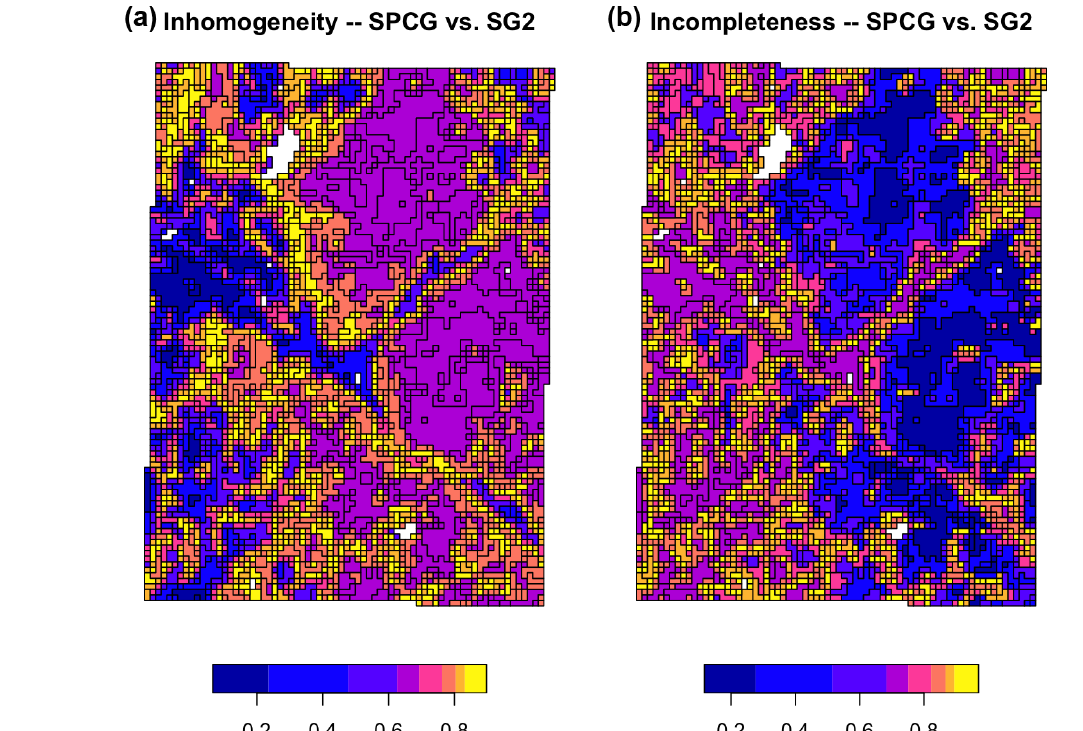
Figure 17. Homogeneity (a) and completeness (b) measures of the SG2 pH class map, with respect to the SPCG pH class map, at 0–5cm. The values are the inhomogeneity of each zone (a) and the incompleteness of each region (b)